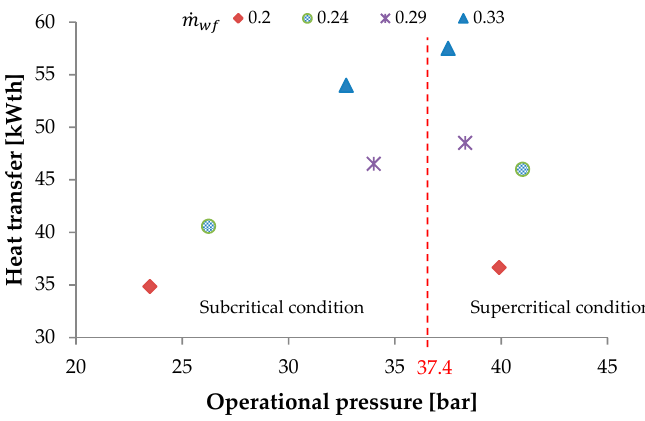
Figure 5. Effects of the system pressure on the heat transfer.